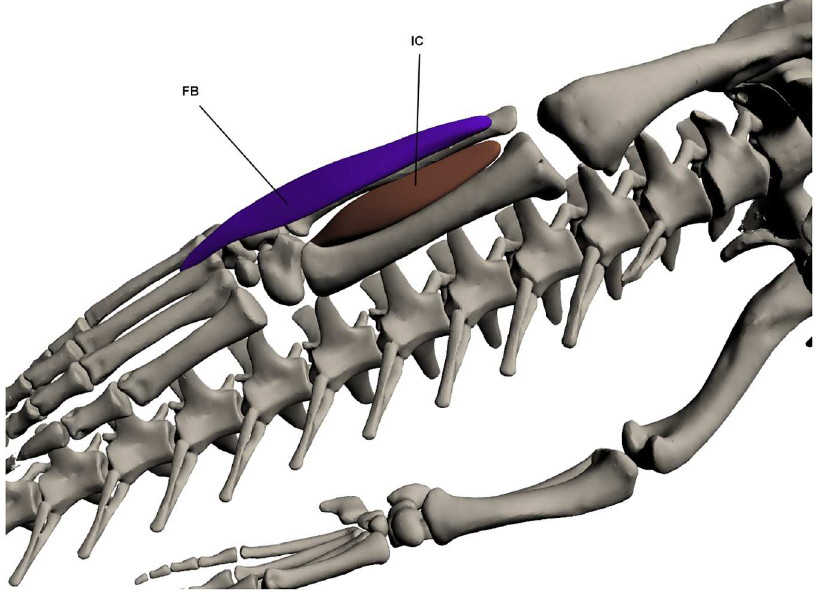
Fig 20. Deep ventral muscles of the lower hindlimb. FB: Fibularisbrevis , IC: Interosseuscruris .